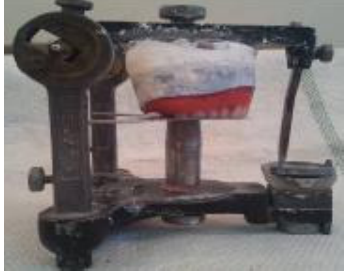
Figure 2: articulator with cast and arranged teeth fixed to the upper member while the metal plate attached to the lower one . For teeth movements, selected points were chosen on the teeth which were: 1. The center of the incisal edge of the right and left central incisors